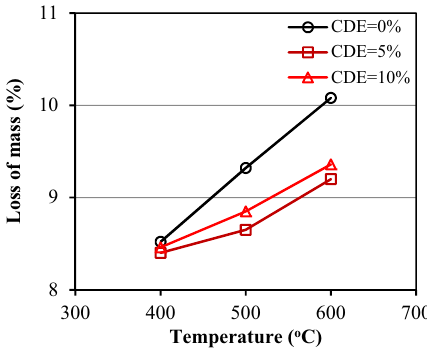
Figure 18: Compressive strength of UHPC after being exposed to high